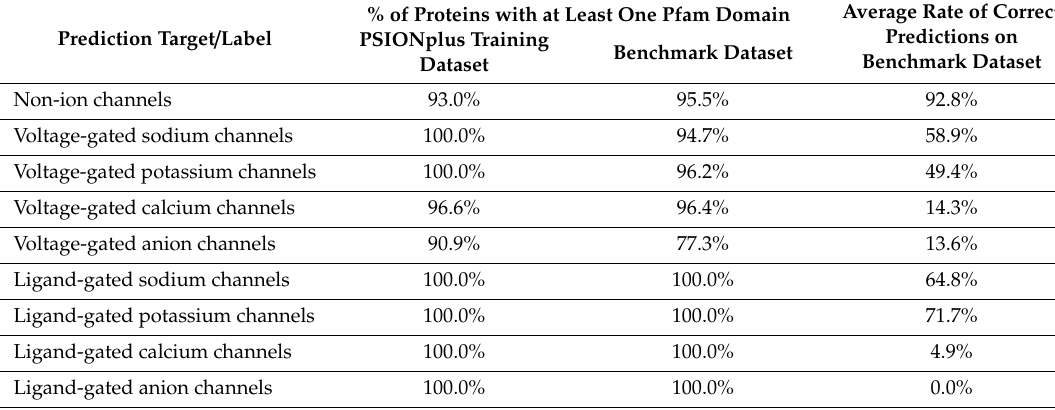
Table 2. Coverage by Pfam domains and the average rate of correct predictions for the domain-based prediction of ion channels and their subtypes. The right-most column is the average of the correct prediction rates across proteins with a given label, where the rate is computed as the number of correctly predicted labels divided by the number of all predicted